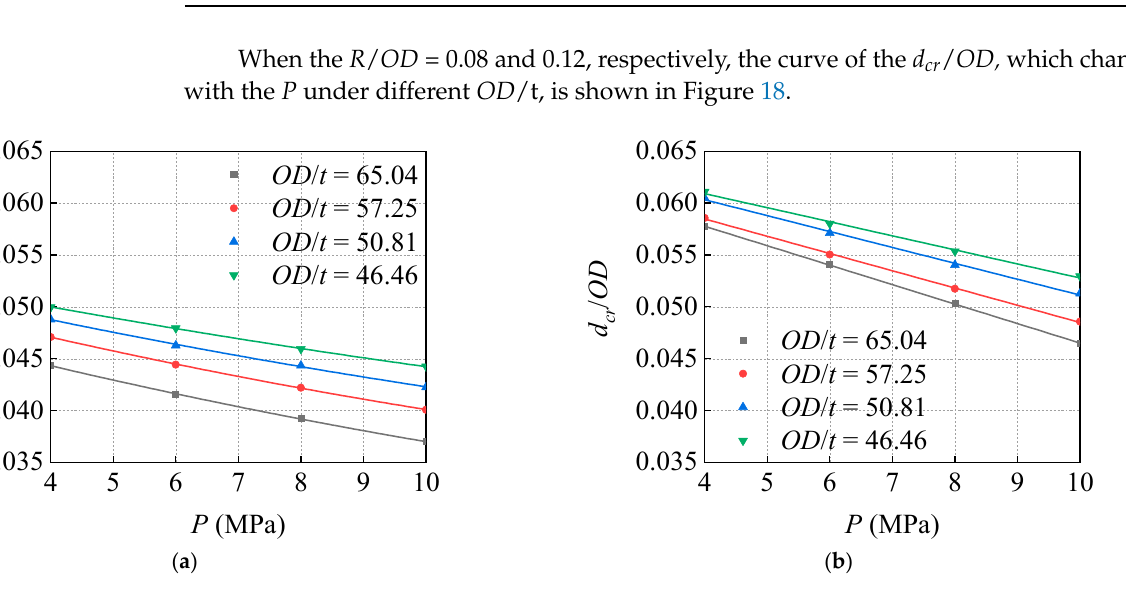
Figure 18. Influence of pressure on critical dent depth under different diameter–thickness ratio: ( a ) R / OD = 0.08, ( b ) R / OD = 0.12. ( a ) R / OD = 0.08, ( b ) R / OD =